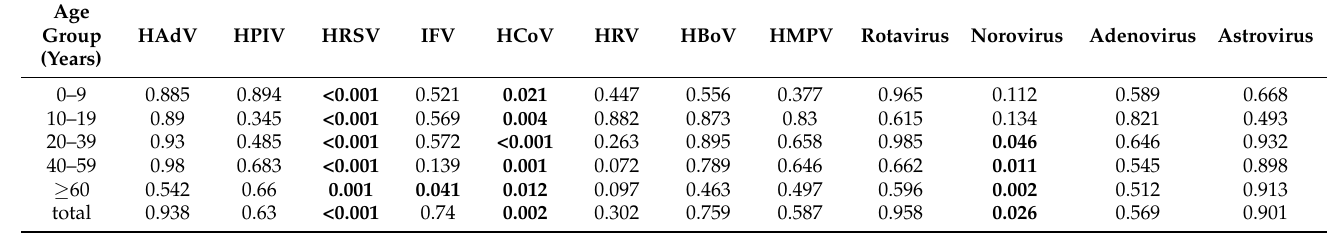
Table 4. Causality of encephalitis incidence after 1 month with virus.